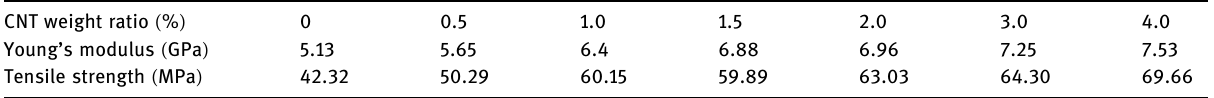
Table 7: Experimental mechanical properties of MWNTs/phenolic composites ( CNTRC ) from ref. [ 29 ] used for CNTFPC rebar